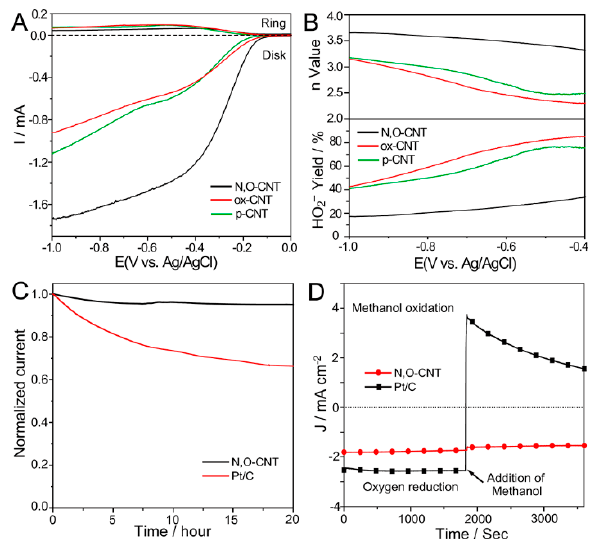
Figure 4. ( A ) Rotating ring disk electrode (RRDE) voltammetric response in the O 2 -saturated 0.1 M KOH at a scan rate of 5 mV s − 1 and ( B ) HO 2 − yields and the corresponding electron transfer number of p-CNT, ox-CNT and N, O-CNT. ( C ) oxygen reduction reaction (ORR) current–time chronoamperometric response of N, O-CNT and Pt/C in O 2 -saturated 0.1 M KOH solution. ( D )